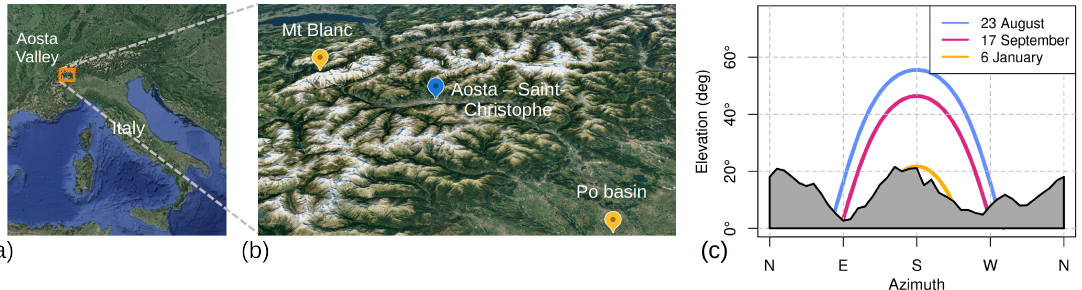
Figure 1. ( a ) The Aosta Valley (coloured rectangle), in northwestern Italy. ( b ) A 3D view of the inves- tigated area: the Aosta–Saint-Christophe observatory (blue marker), together with the geographical references of Mont Blanc (4808 m a.s.l., the highest mountain in the European Alps) and the Po Valley, extending from the southeastern side of the Aosta Valley to the most part of northern Italy. Images from Google Earth. ( c ) Local horizon and solar elevation angles during three days representative of the short-term campaigns